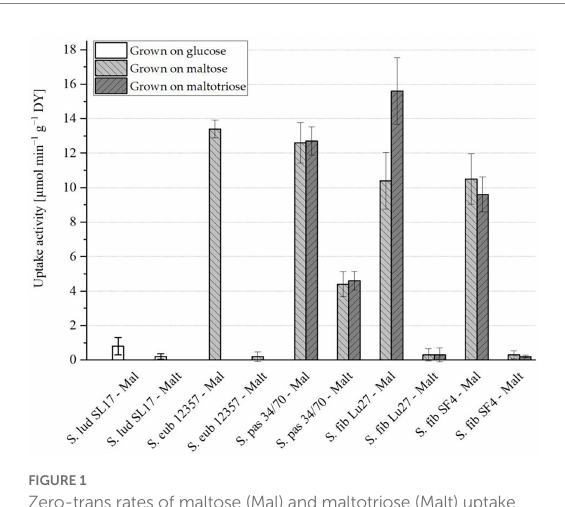
FIGURE 1 Zero-trans rates of maltose (Mal) and maltotriose (Malt) uptake